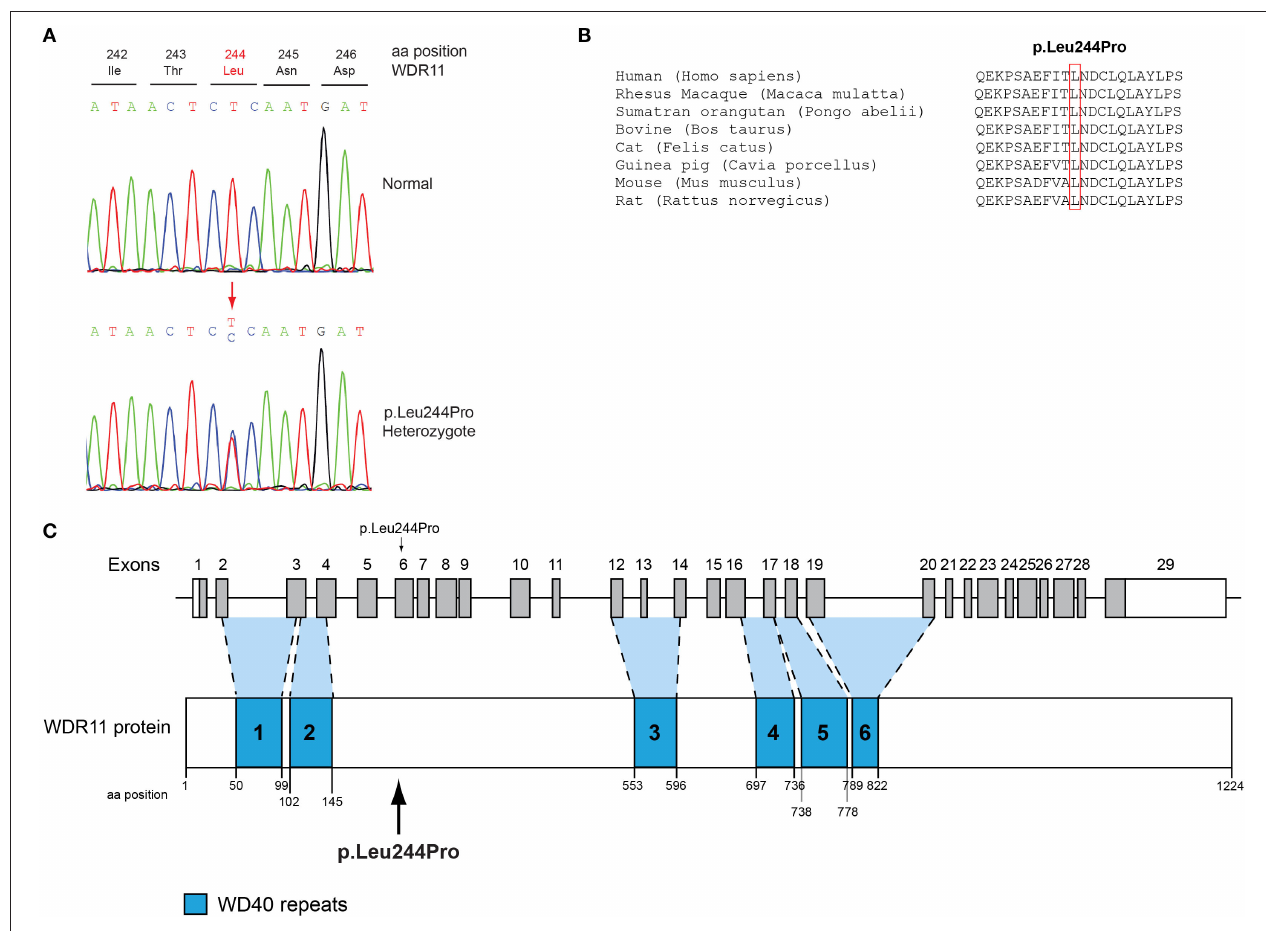
FIGURE 2 | Identification of a novel p.Leu244Pro WDR11 variant. (A) Sequence electropherogram of the novel WDR11 p.Leu244Pro variant. (B) Multiple sequence alignment of the amino acid at position 244 of the WDR11 protein from various species. The conserved leucine amino acid at position 244 is indicated by red color. (C) Schematic representation of the WDR11 gene and protein of a male patient identified with the novel p.Leu244Pro variant.